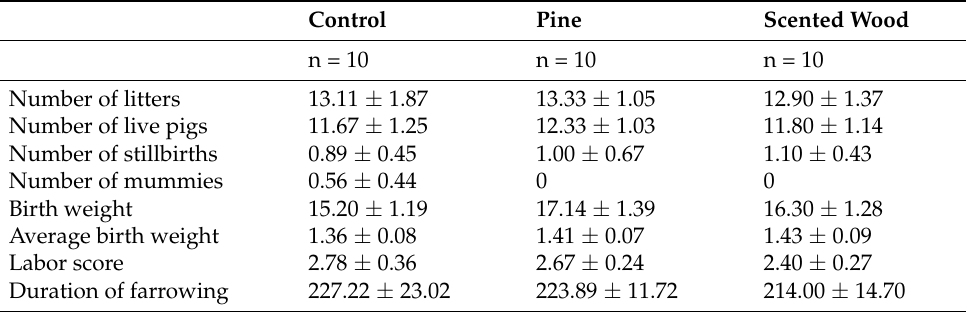
Table 4. Effect of enrichment items on the reproductive performance of late pregnant sows. Control Pine Scented Wood n =